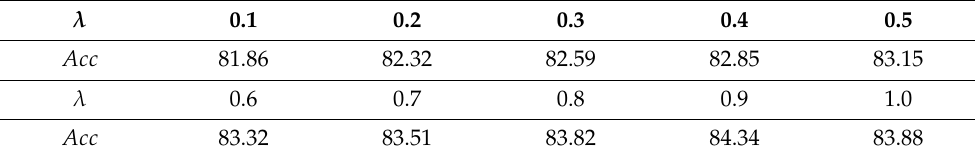
Table 3. λ ’s influence on classification accuracy.